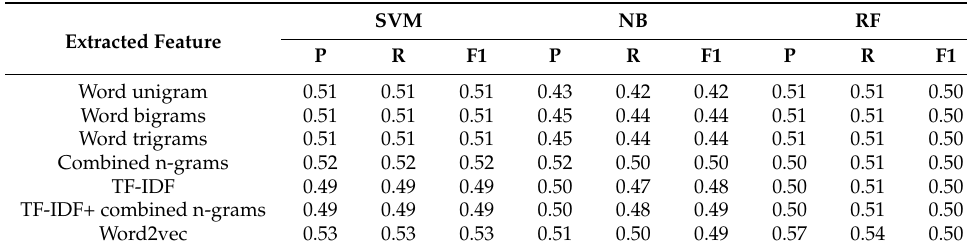
Table 14. Classification performance result of ternary models.